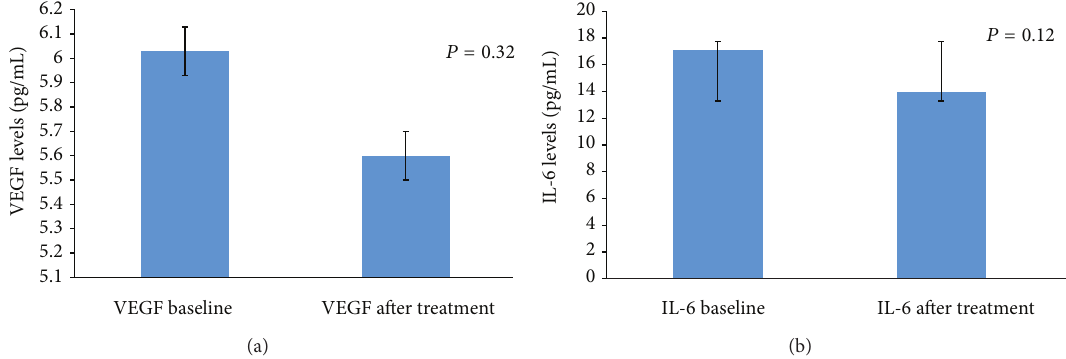
Figure 1: Column chart showing the change in mean aqueous VEGF levels (a) and change in mean aqueous IL-6 levels (b) in the study patients. The error bar represents standard deviation.